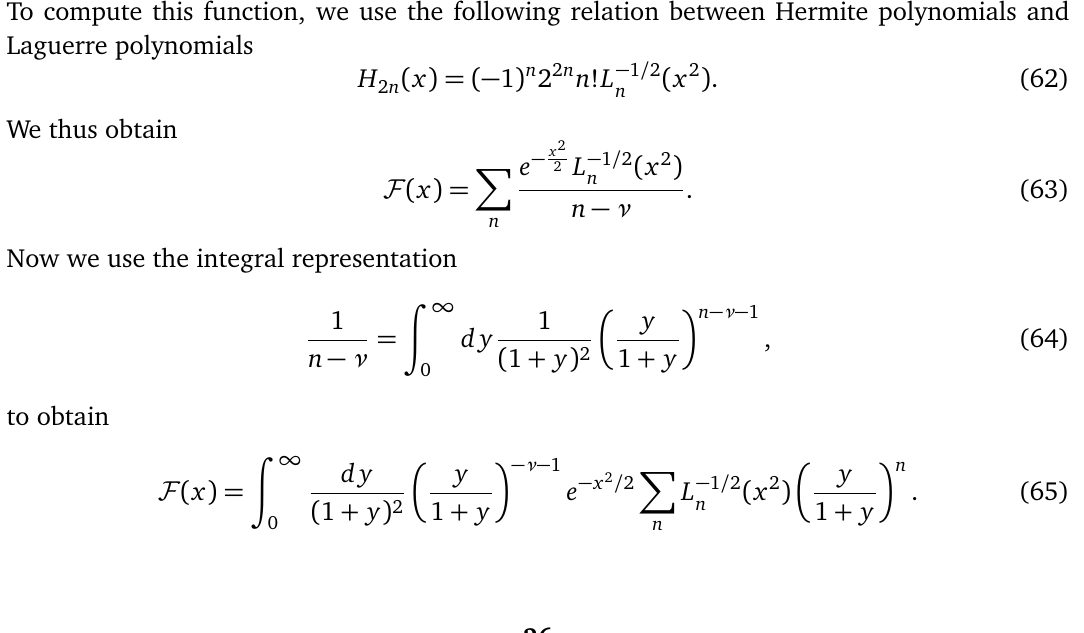
Figure 13: Position space density for the ground state at g well potential in Figure 1 for the 6 + 1 system. The density profile localized in the left well is the minority density and the other one is the majority